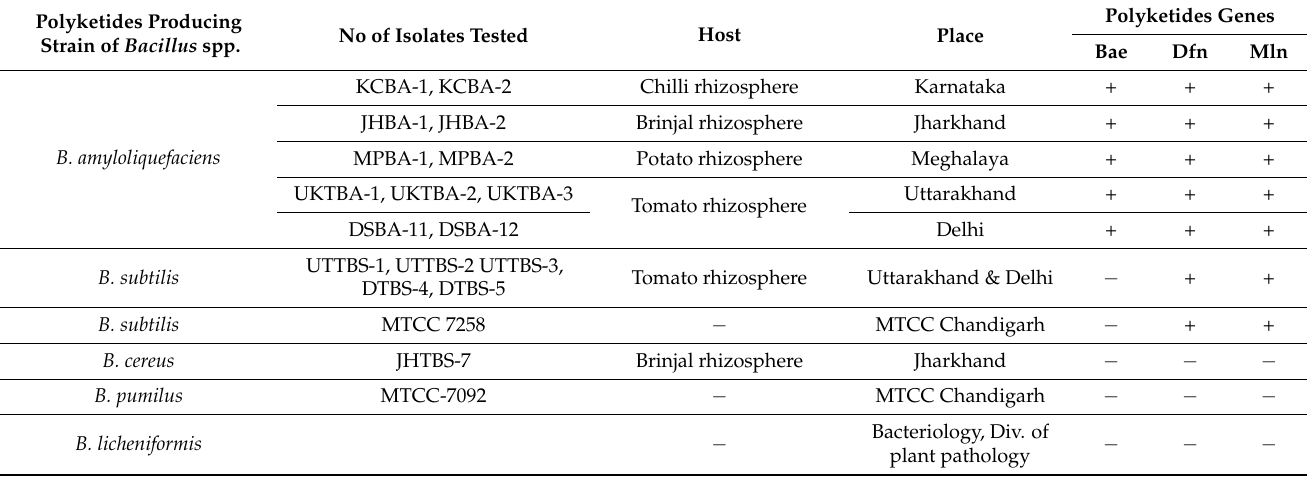
Table 3. Screening of polyketide antibiotics producing strains of Bacillus spp. isolated from rhizo- spheric soil of solanaceous crops.